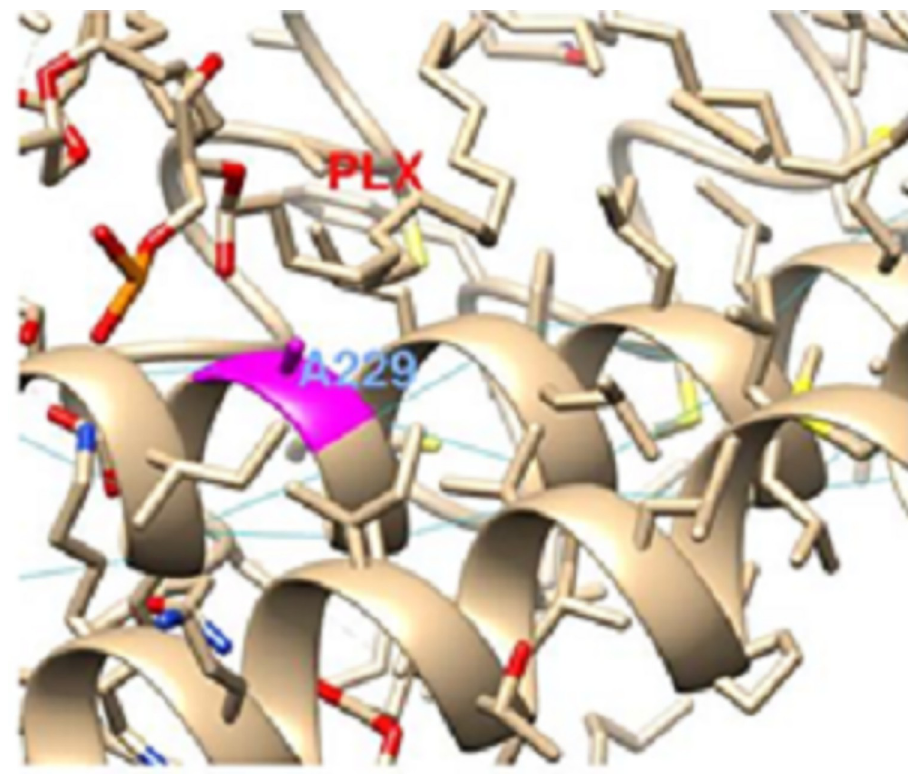
Fig 3. Position of A 229 in